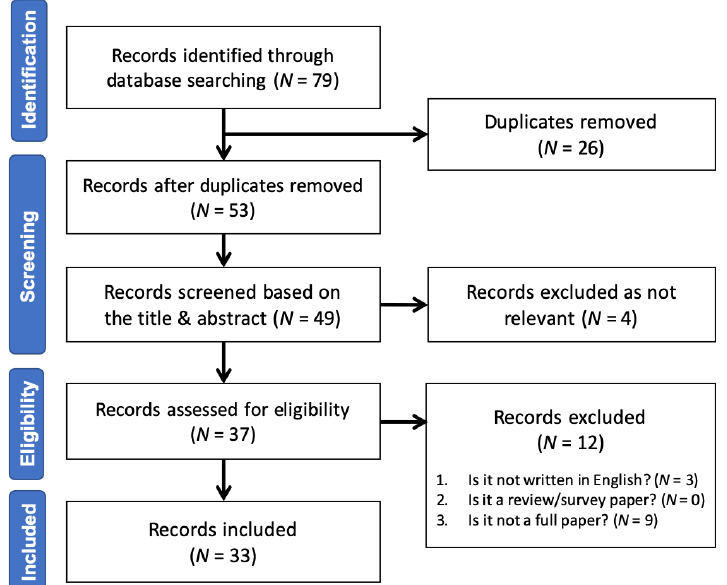
Figure 1. A PRISMA flow diagram that shows the process of identifying eligible papers on touchscreen-based image accessibility for people who are blind or have visual